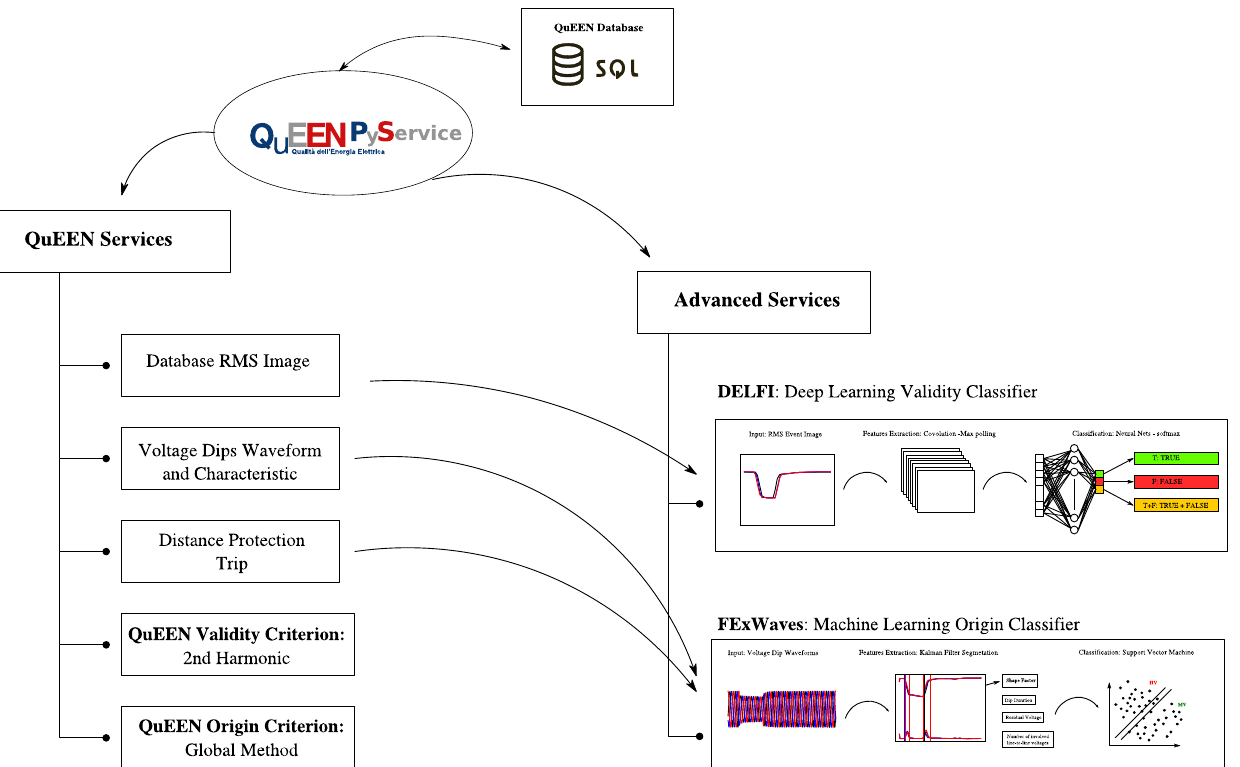
Figure 7. QuEEN PyService architecture.